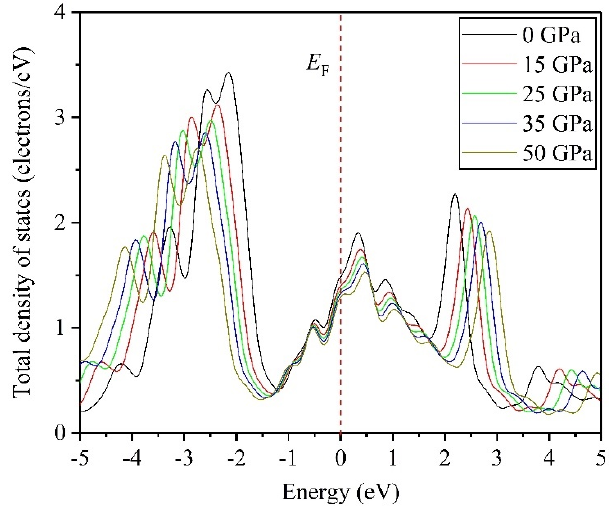
Figure 11. TDOS for the NiTi SMA under different pressures.